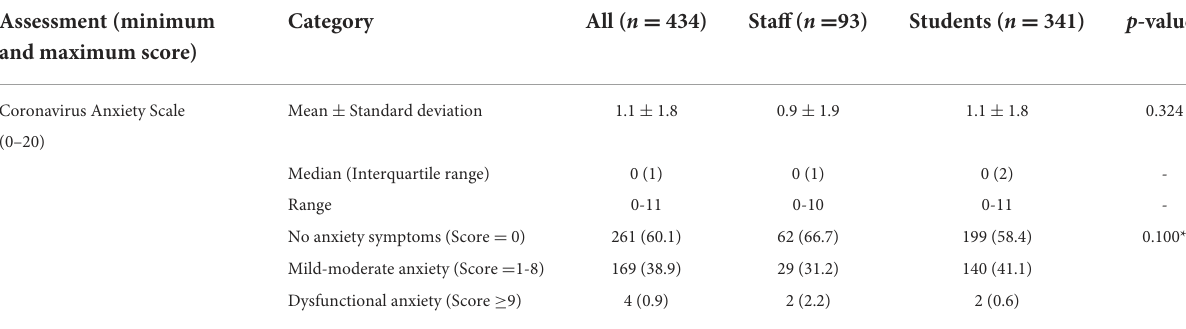
TABLE 5 Summary of result on anxiety level related to the COVID-19 pandemic ( n = 434). Assessment